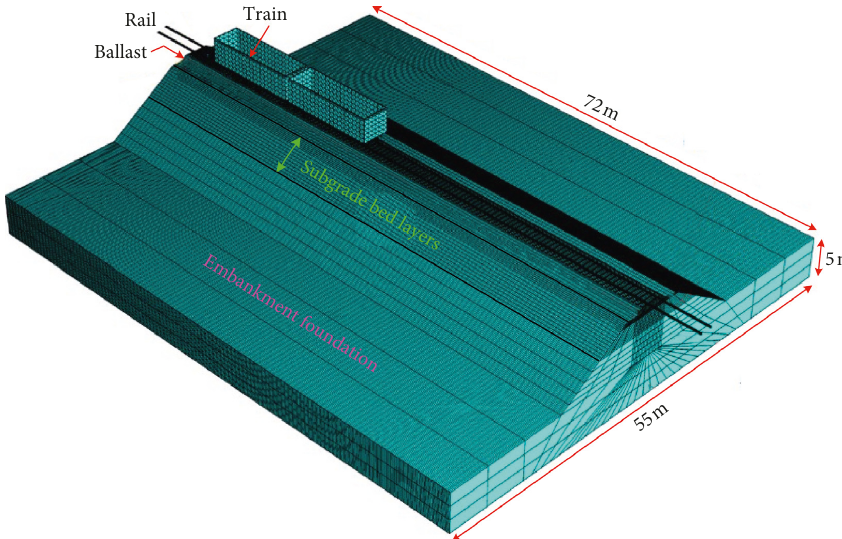
Figure 5: Train-track-subgrade interaction